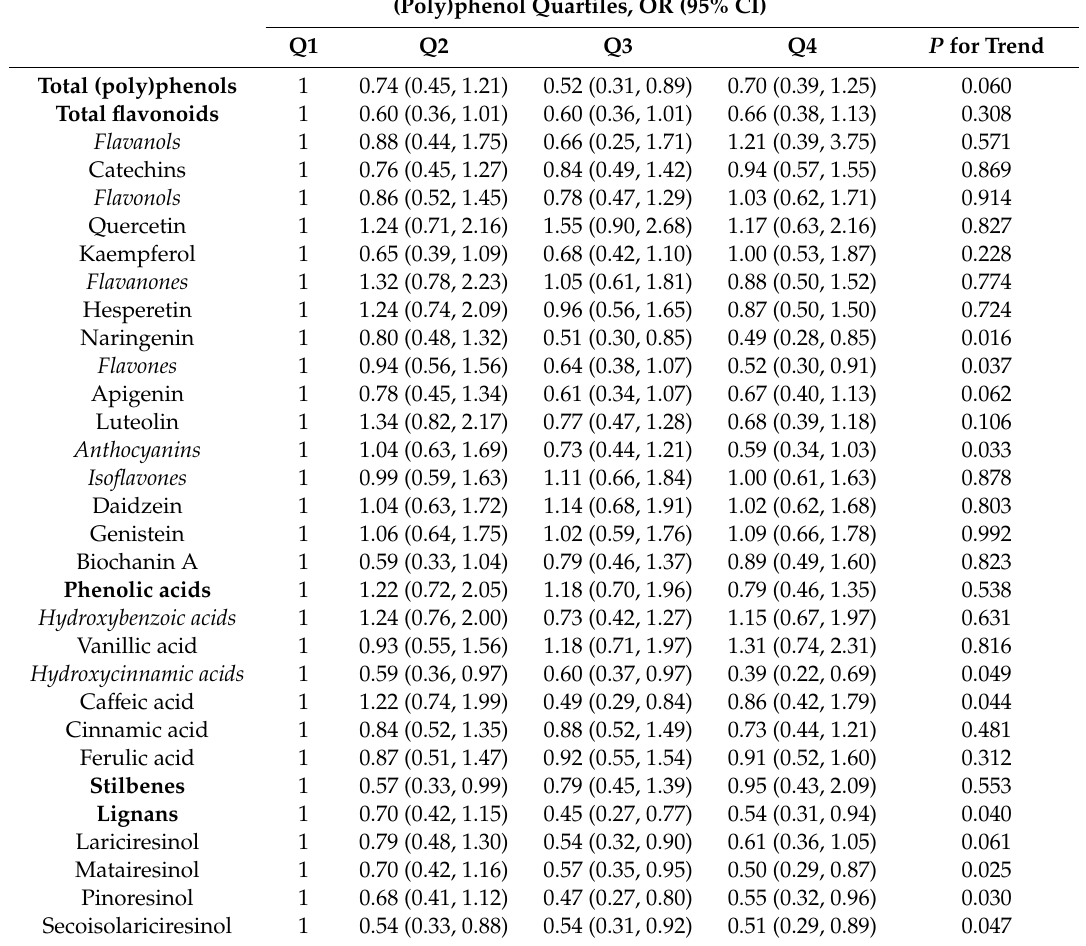
Table 3. Odds ratios (ORs) and 95% confidence intervals (CIs) for the associations between (poly)phenol intake (total, main classes, subclasses and individual compounds) and adequate sleep quality in normal weight